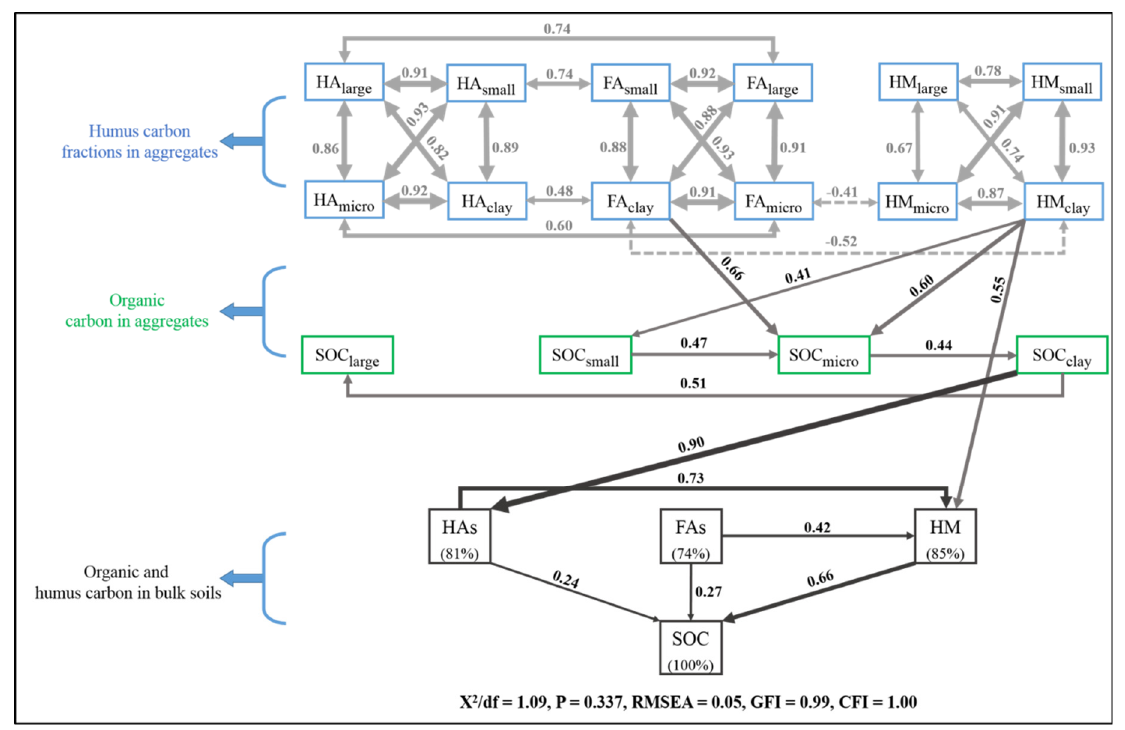
Figure 6. Structural equation model showing the direct and indirect effects of soil organic carbon (SOC), humic acids (HAs) carbon, fulvic acids (FAs) carbon and humin (HM) carbon within aggregates on organic and humus carbon in bulk soil. Note, the solid and dashed arrows represent the positive and negative relationships between variables, respectively. The number on the arrow represents the standardized path coefficient, the thickness of the arrow indicates the magnitude of the path coefficient, and the percentage is the total variance explained by the